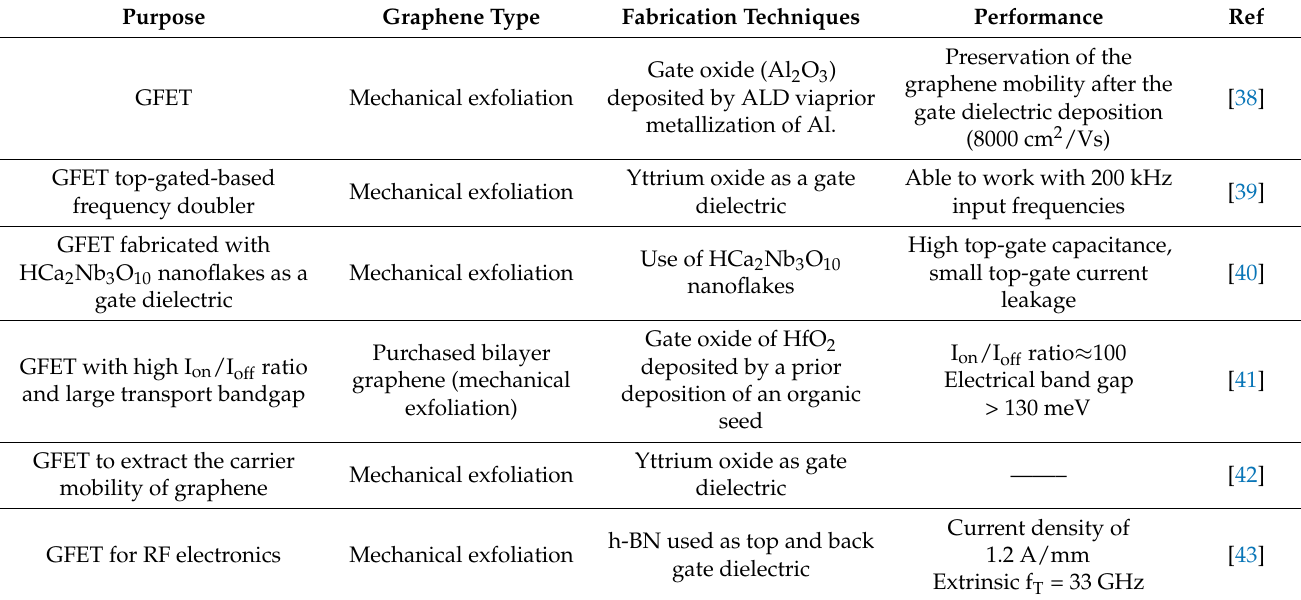
Table 3. Top-/back-gated graphene transistors.